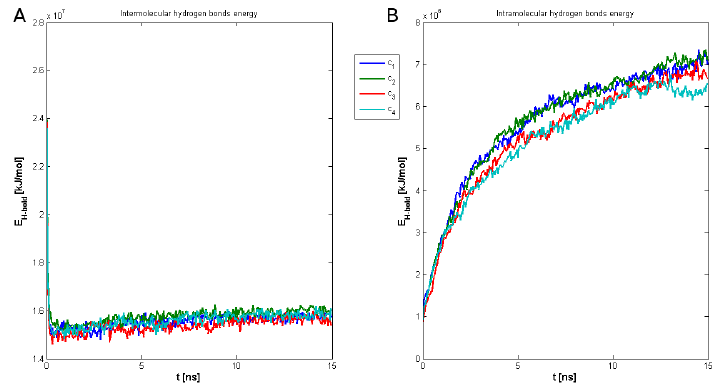
Figure 3. Total hydrogen bond energy in normal HA networks with increasing concentration of phospholipids: ( A ) intra-molecular H-bond energy is depicted; and ( B ) inter-molecular bond